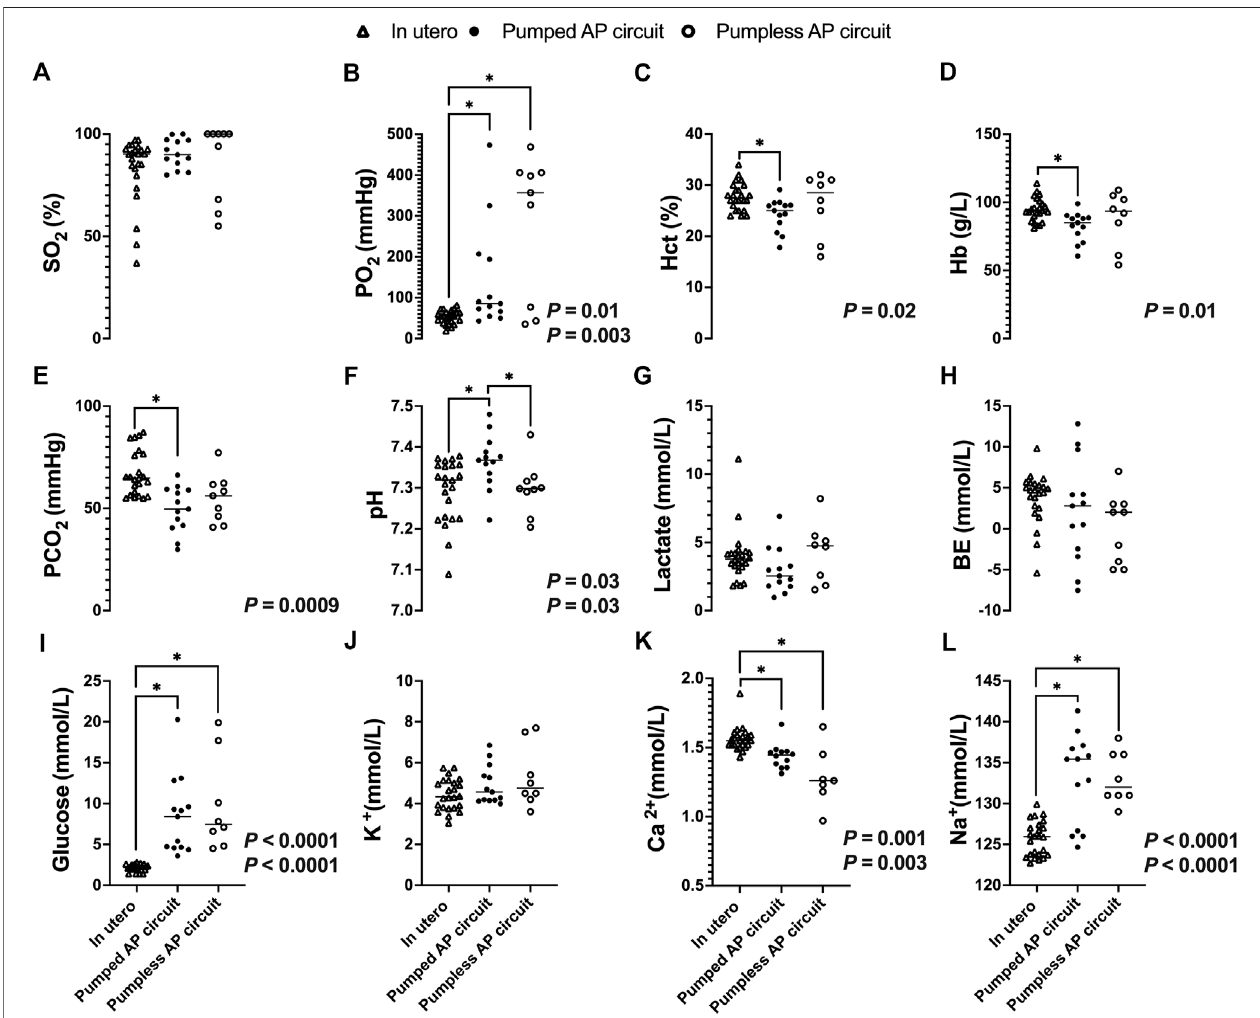
FIGURE8 | Blood gases, electrolytes, lactate,and glucose concentrations infetal pigs studied inutero versusfetal pigs supported using apumped and pumpless AP circuit (Charest-Pekeski et al., 2021). In utero fetal pig data represented by open triangles ( n = 24), fetal pigs supported on a pumped AP circuit as black circles ( n = 13), and fetuses supported on apumpless APcircuit asopen circles( n = 9). (A) SO 2 , (B) PO 2 , (C) Hct, (D) Hb, (E) PCO 2 , (F) pH, (G) Lactate, (H) BE, (I) Glucose, (J) K + , (K) Ca 2+ , and (L) Na+. If two p- values are presented, the fi rst p- values represents the pumped AP circuit, and the second p- value represents the pumpless AP circuit. Data for pumped and pumpless AP circuits are presented as an average for the entire duration of support.